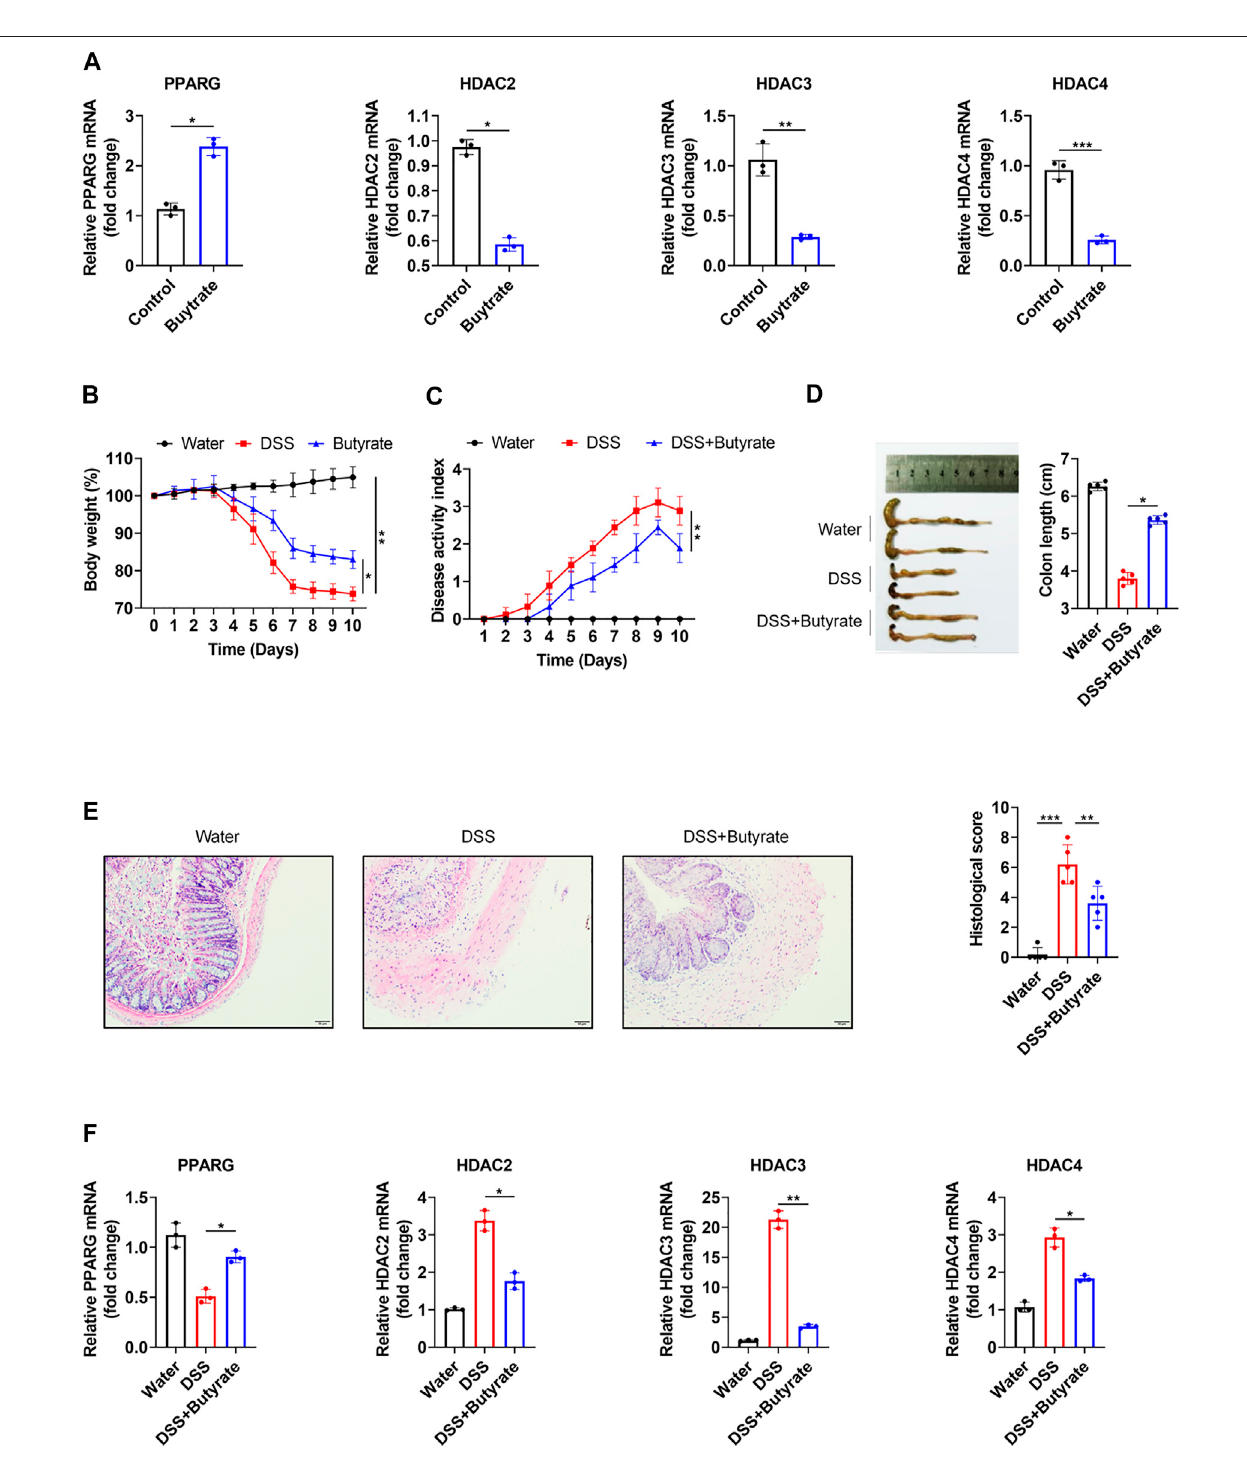
FIGURE 6 | PPARG and HDACs can be regulated by butyrate. (A) PPARG, HDAC2, HDAC3 and HDAC4 mRNA levels were determined in Caco-2 cells treated with butyrate (5 mM) for 24 h; B57BL/6 mice were administered 2.5% DSS in drinking water for 7 days, followed by 3 days of water, in the presence or absence of butyrate (200 mM) (n (cid:1) 5 per group). (B) Body weight, (C) DAI score, (D) colon length, (E) HE staining (200 × magni fi cation) and histological scores or vechale. (F) PPARG,HDAC2,HDAC3,andHDAC4mRNAlevels incolonicepithelialcells.Thedatashownarethemean ± SDand represent threeindependentexperiments, p values were calculated using unpaired t-test, * p < 0.05, ** p < 0.01, *** p < 0.001, ns (cid:1) not signi fi cant.